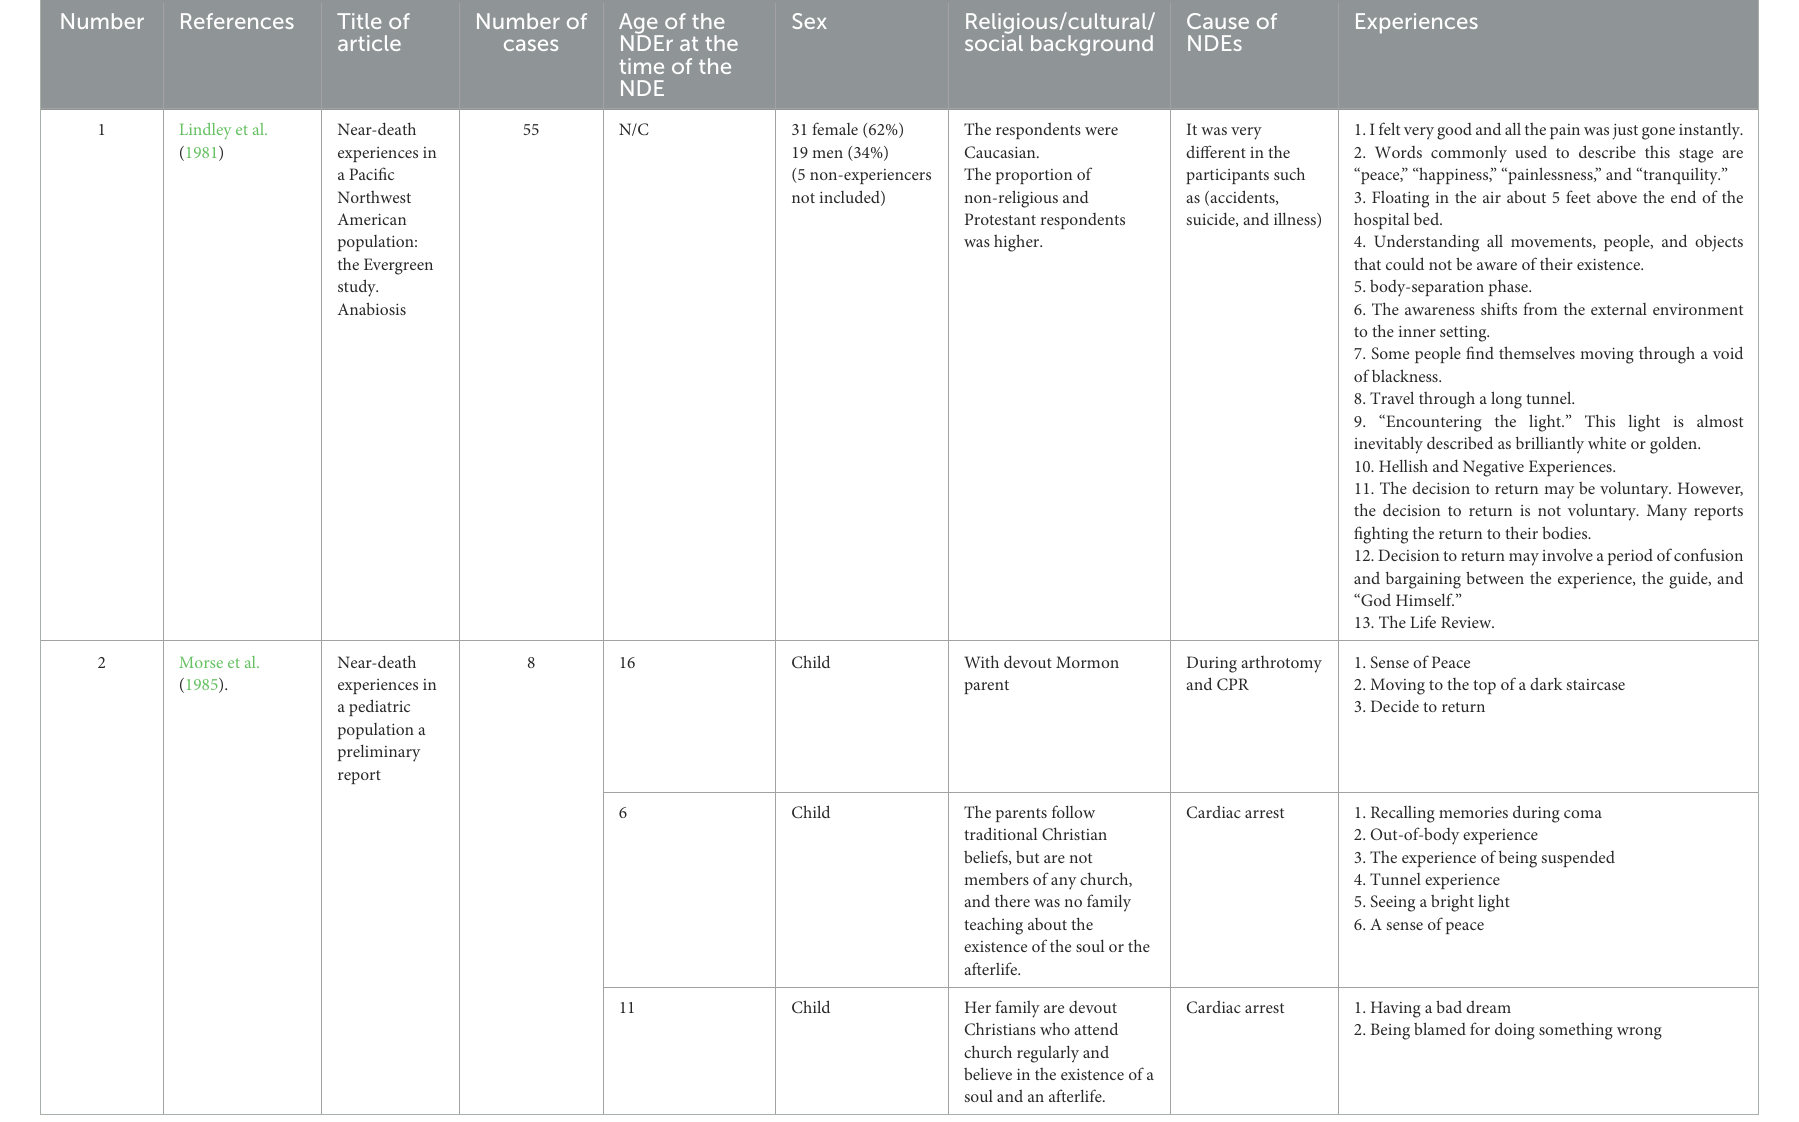
TABLE 3 Characteristics of the case series and qualitative studies and background detail of near-death experiencers ( N =